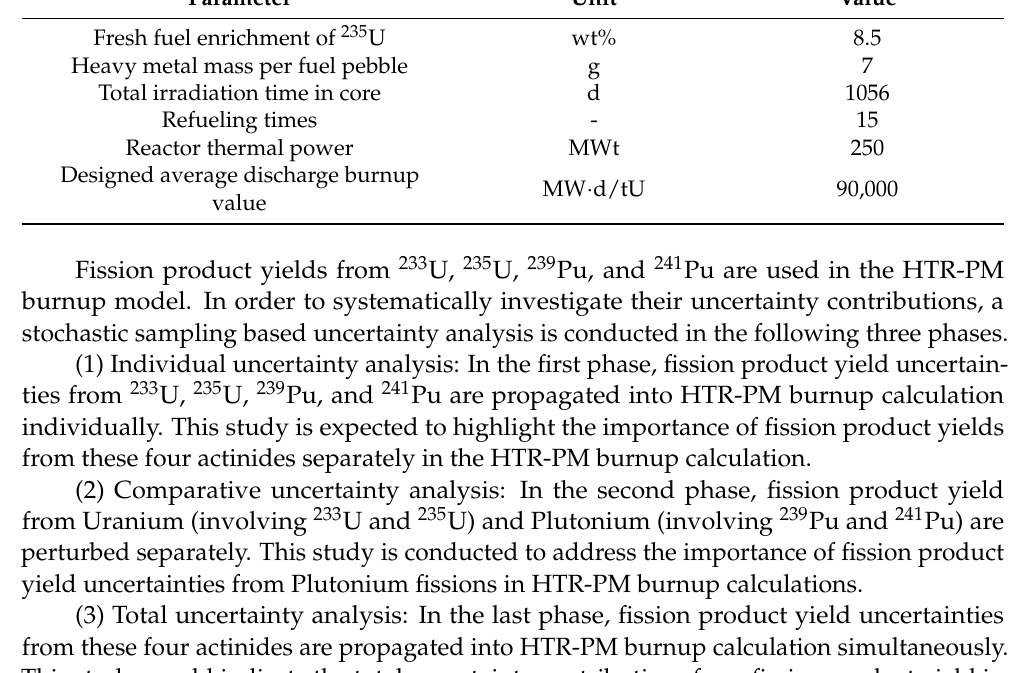
Table 1. HTR-PM main burnup model parameters. Parameter